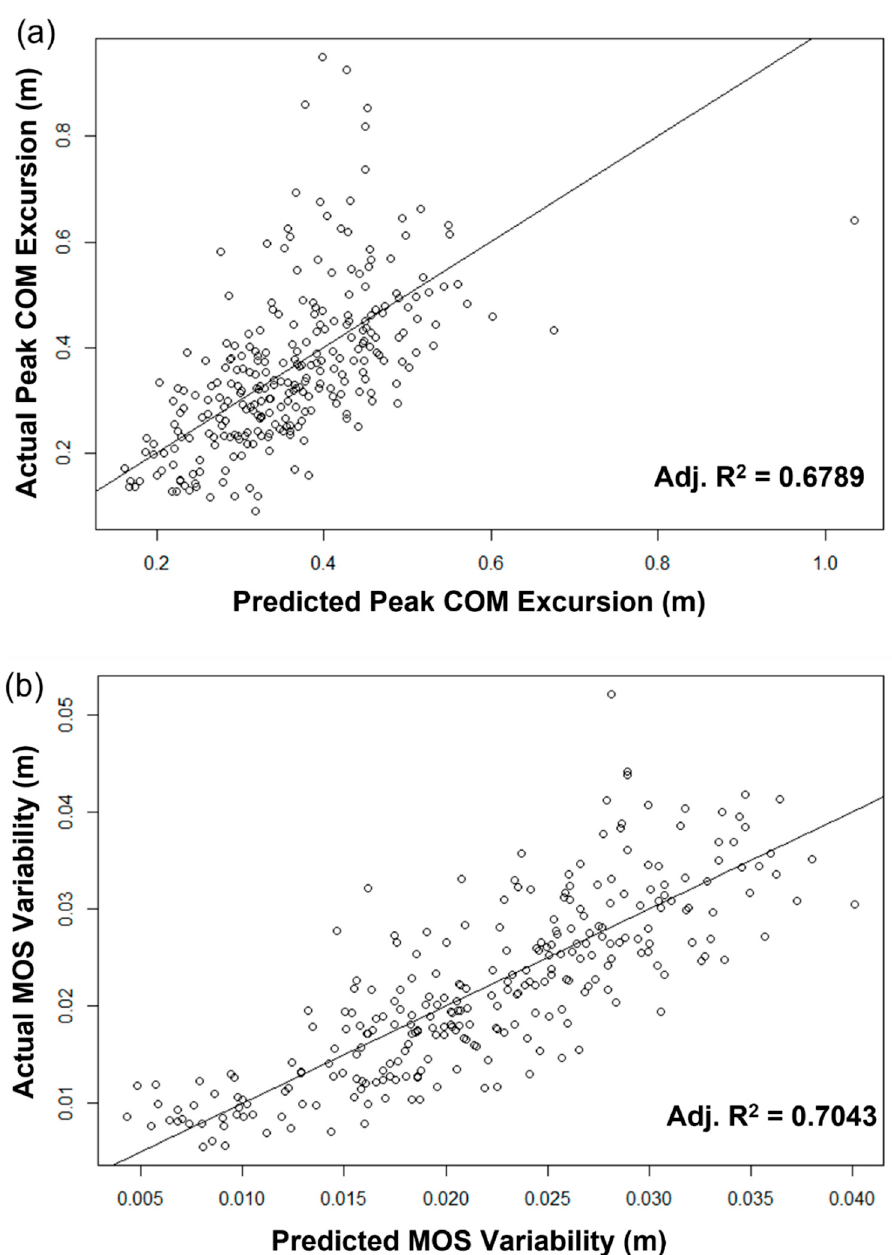
Figure 2. Scatter plots for predicted results vs. actual values: ( a ) peak COM excursion and ( b ) MOS variability.